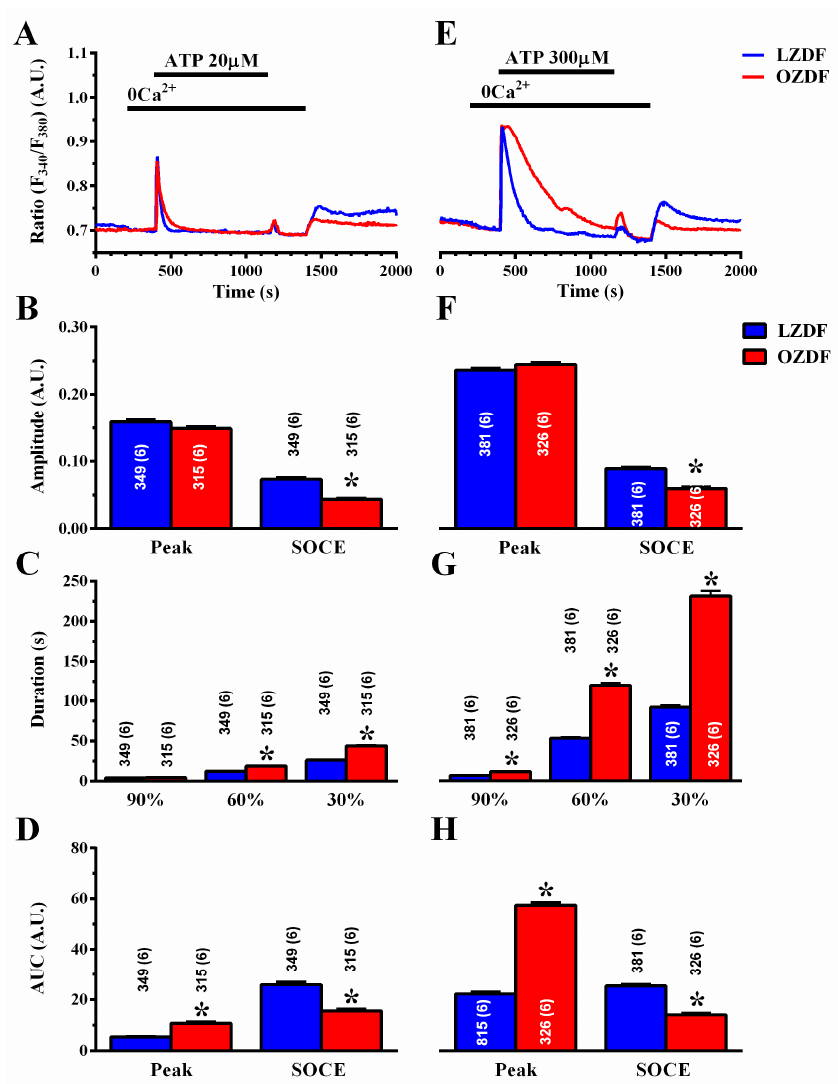
Figure 4. The “Ca 2 + add-back” protocols reveal subtle alterations in endogenous Ca 2 + release and SOCE down-regulation in native aortic endothelium of obese Zucker Diabetic Fatty rats. ( A ) Representative recordings of the “Ca 2 + add-back” protocol obtained from native aortic endothelium of LZDF and OZDF rats challenged with 20 µ M ATP in absence of extracellular Ca 2 + (0Ca 2 + ). Subsequently, extracellular Ca 2 + was returned to the perfusate to activate SOCE. Before SOCE activation, ATP was removed to avoid P 2X receptor and second messengers-operated channel activation. ( B ) Mean ± SE of endogenous Ca 2 + release and SOCE amplitude recorded in native aortic endothelium of LZDF and OZDF rats challenged with 20 µ M ATP. The asterisk indicates p < 0.05. ( C ) Mean ± SE of the duration of the Ca 2 + response to 20 µ M ATP in LZDF and OZDF rats. The asterisk indicates p < 0.05. ( D ) Mean ± SE of the AUC of the two distinct components (i.e., endogenous Ca 2 + release and SOCE) of the Ca 2 + response to 20 µ M ATP in LZDF and OZDF rats. The asterisk indicates p < 0.05. ( E ) Representative recordings of the “Ca 2 + add-back” protocol obtained from native aortic endothelium of LZDF and OZDF rats challenged with 300 µ M ATP in absence of extracellular Ca 2 + (0Ca 2 + ). Subsequently, extracellular Ca 2 + was returned to the perfusate to activate SOCE. ( F ) Mean ± SE of endogenous Ca 2 + release and SOCE amplitude recorded in native aortic endothelium of LZDF and OZDF rats challenged with 300 µ M ATP. The asterisk indicates p < 0.05. ( G ) Mean ± SE of the duration of the Ca 2 + response to 300 µ M ATP in LZDF and OZDF rats. The asterisk indicates p < 0.05. ( H ) Mean ± SE of the AUC of the two distinct components (i.e., endogenous Ca 2 + release and SOCE) of the Ca 2 + response to 300 µ M ATP in LZDF and OZDF rats. The asterisk indicates p < 0.05, Mann-Whitney